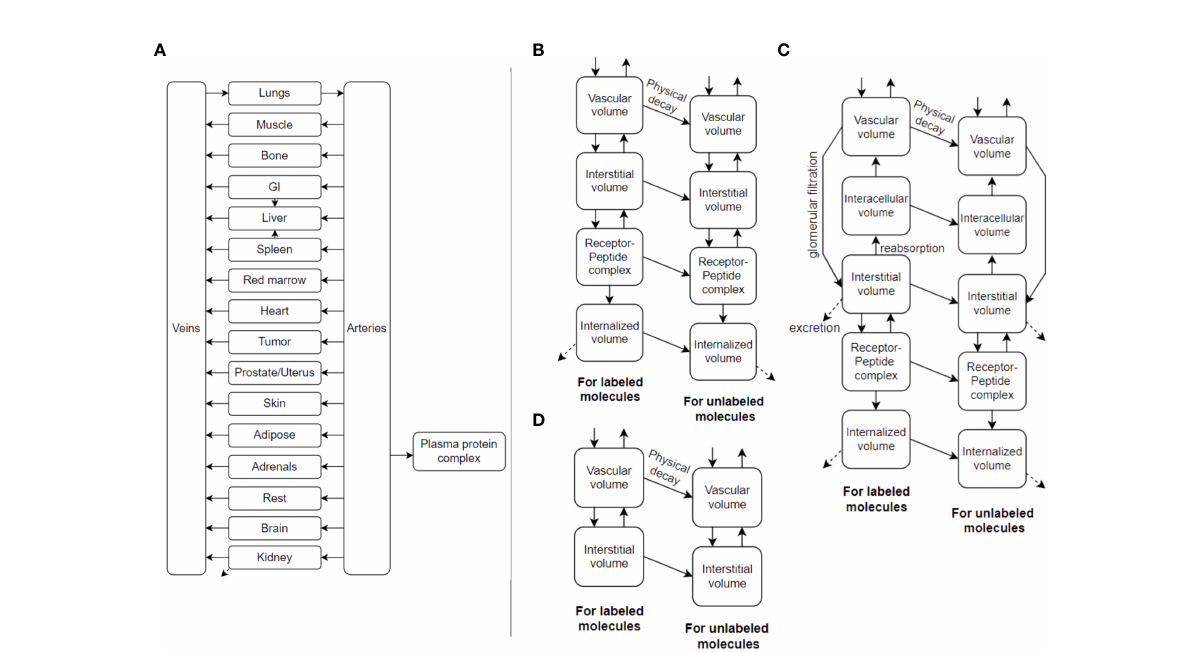
FIGURE 2 (A) An example PBPK model, utilizing ordinary differential equations (ODEs), which can also be called Physiologically-Based RadioPharmacoKinetic (PBRPK) Model. This model include organs (B) with and (D) without receptors, and includes (C) the kidney which has more sophisticated modeling. Radiopharmaceutical exchange (hot and cold components) between the different compartments is also